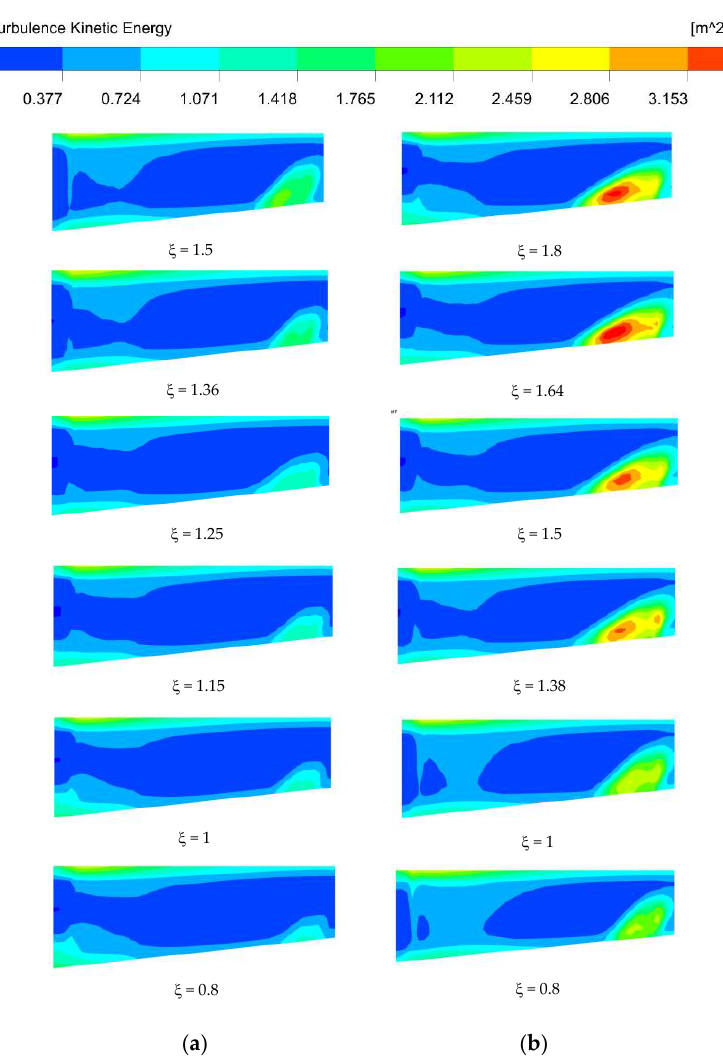
Figure 18. Turbulent kinetic energy of meridional surface with different thickening schemes. ( a ) Scheme 1 with δ hmax = 7.5 mm and ( b ) scheme 4 with δ hmax = 9 mm.